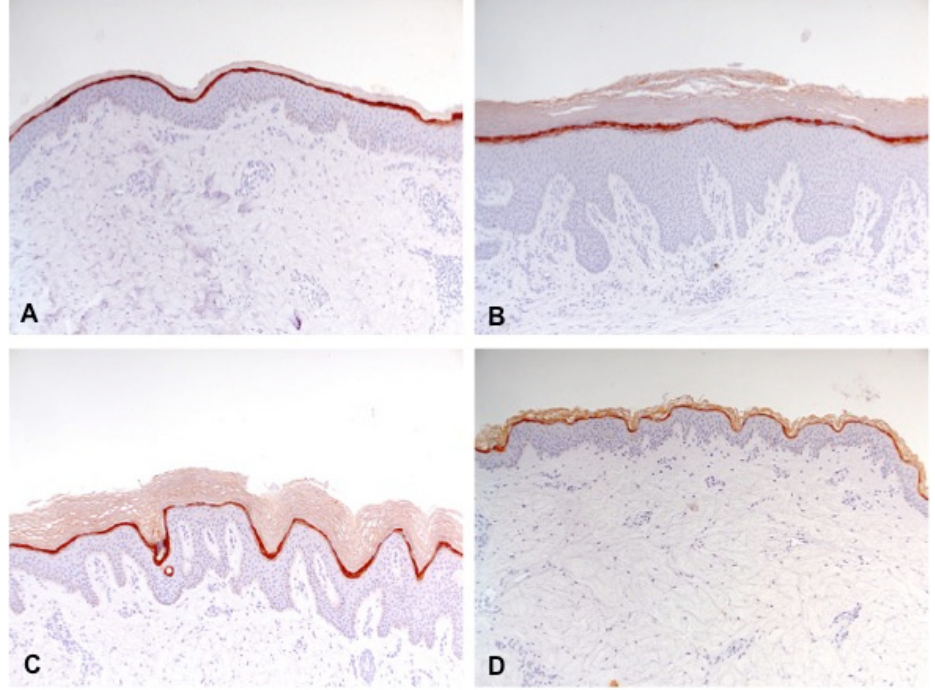
Figure 5. Increased expression of loricrin (thickening and staining density of the brown staining line) in lesional skin of classic atopic dermatitis ( A ), atopic prurigo ( B ), and non-atopic prurigo nodularis ( C ) compared with healthy controls ( D ) shown by immunohistochemistry (100-fold magnification).